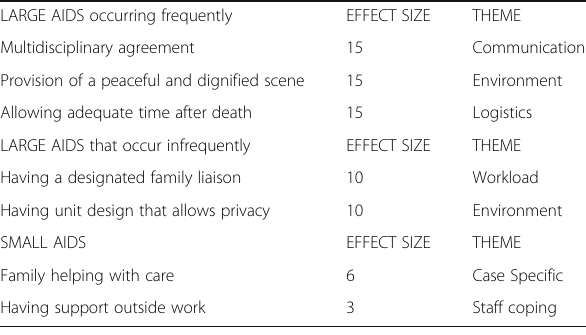
Table 24 (abstract A43). Effect size and themes of aids LARGE AIDS occurring